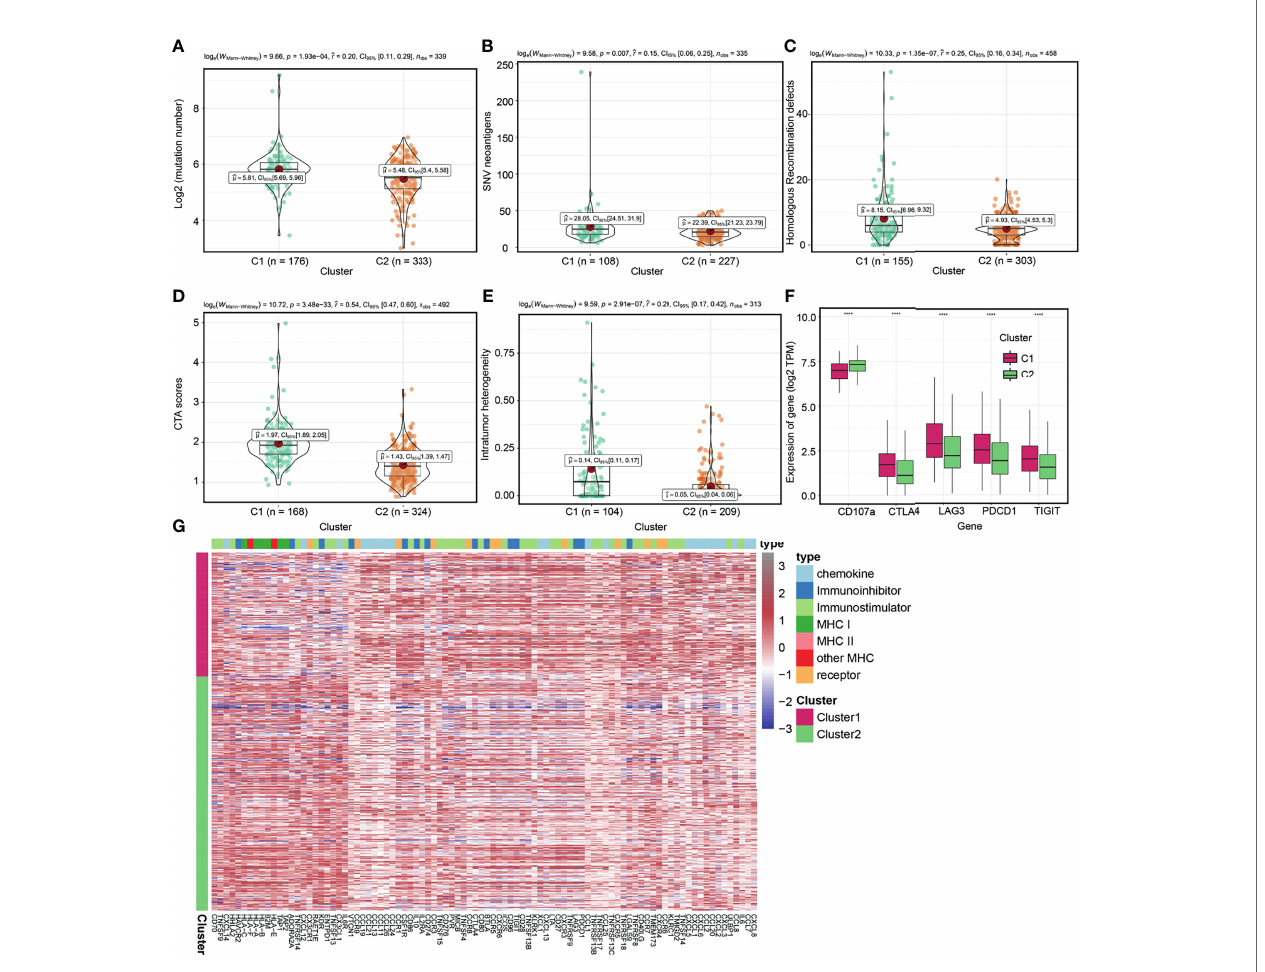
FIGURE 5 | Exploration of intrinsic immune escape mechanisms among molecular clusters. Comparison of tumor mutation burden (TMB) (A) , neoantigen load (B) , homologous recombination defects (HRD) (C) , CTA scores (D), and intratumor heterogeneity (ITH) (E) among the two clusters. (F) Comparison of immunomodulators among the two molecular clusters. (G) Heatmap displaying gene clusters of immunomodulators in the two clusters. (**** P <